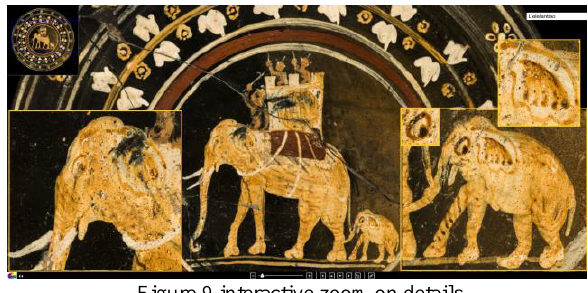
Figure 9 interactive zoom on details